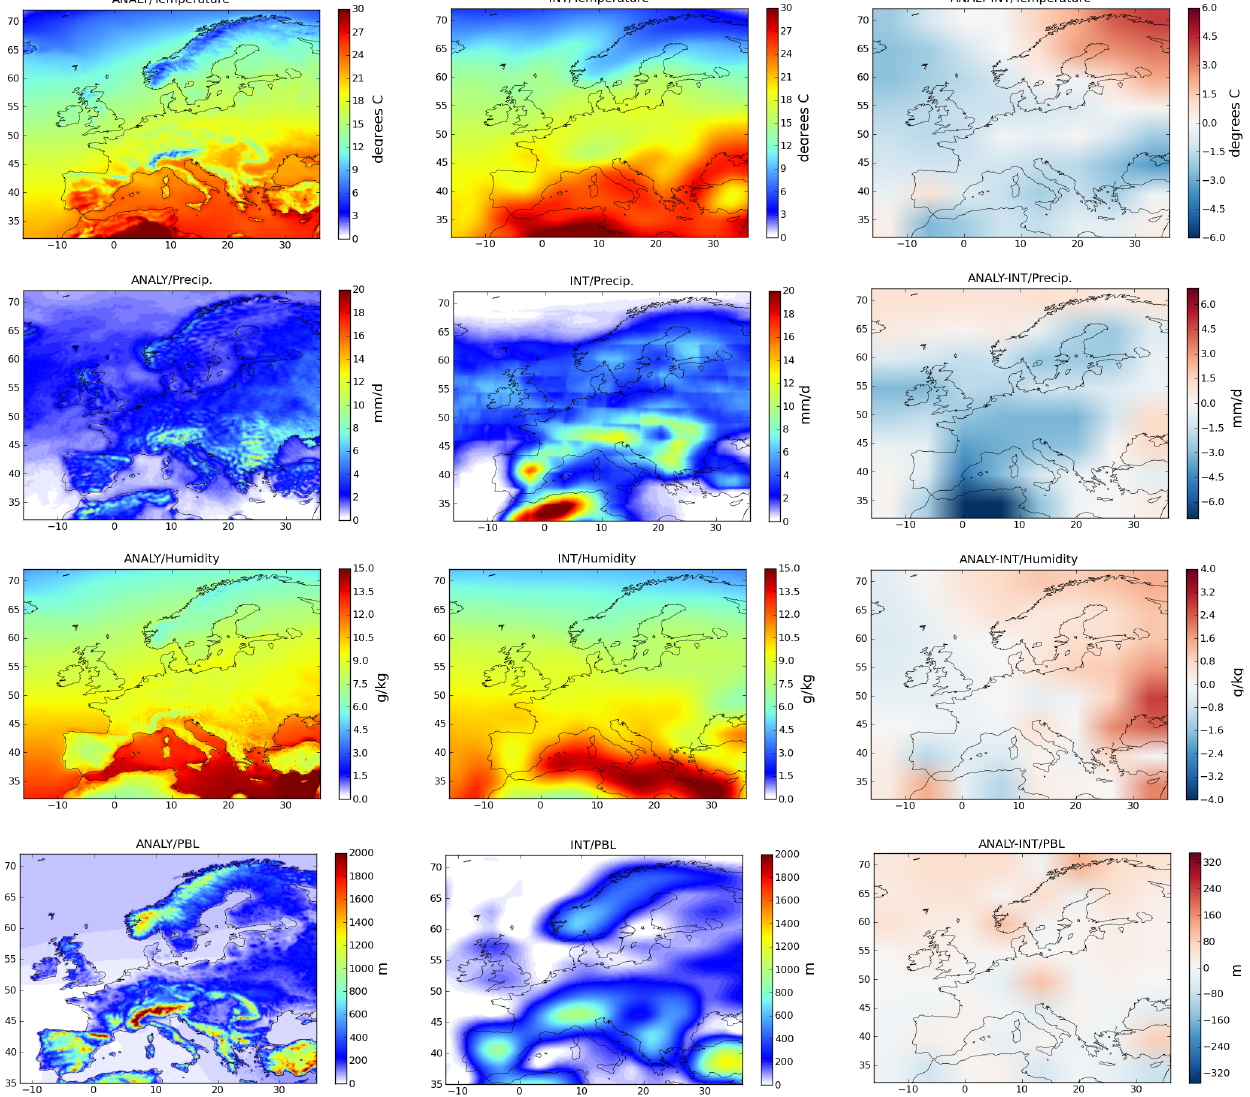
Fig. 2. From top to bottom: average summertime surface temperature ( ◦ C), precipitation (mm d − 1 ), humidity (g kg − 1 ) and planetary boundary layer height (m) for the summer period (JJAS) of ANALY and INT. Differences between ANALY and INT are shown on the right.